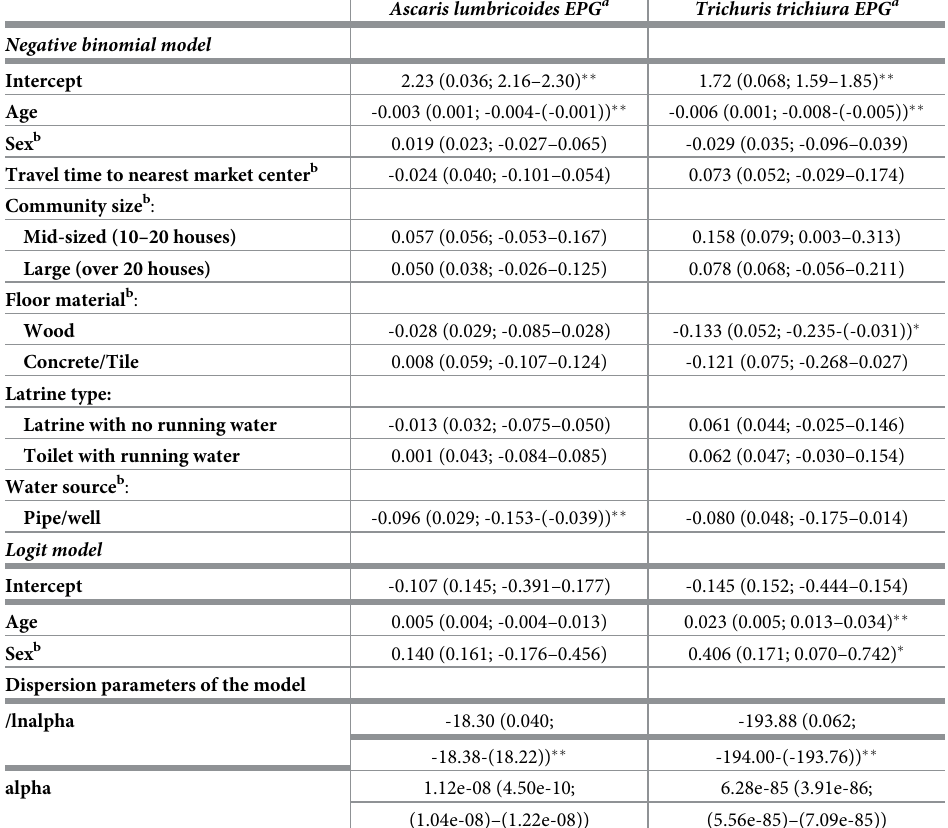
Table 5. Associations between specific aspects of household infrastructure and helminth infection intensity